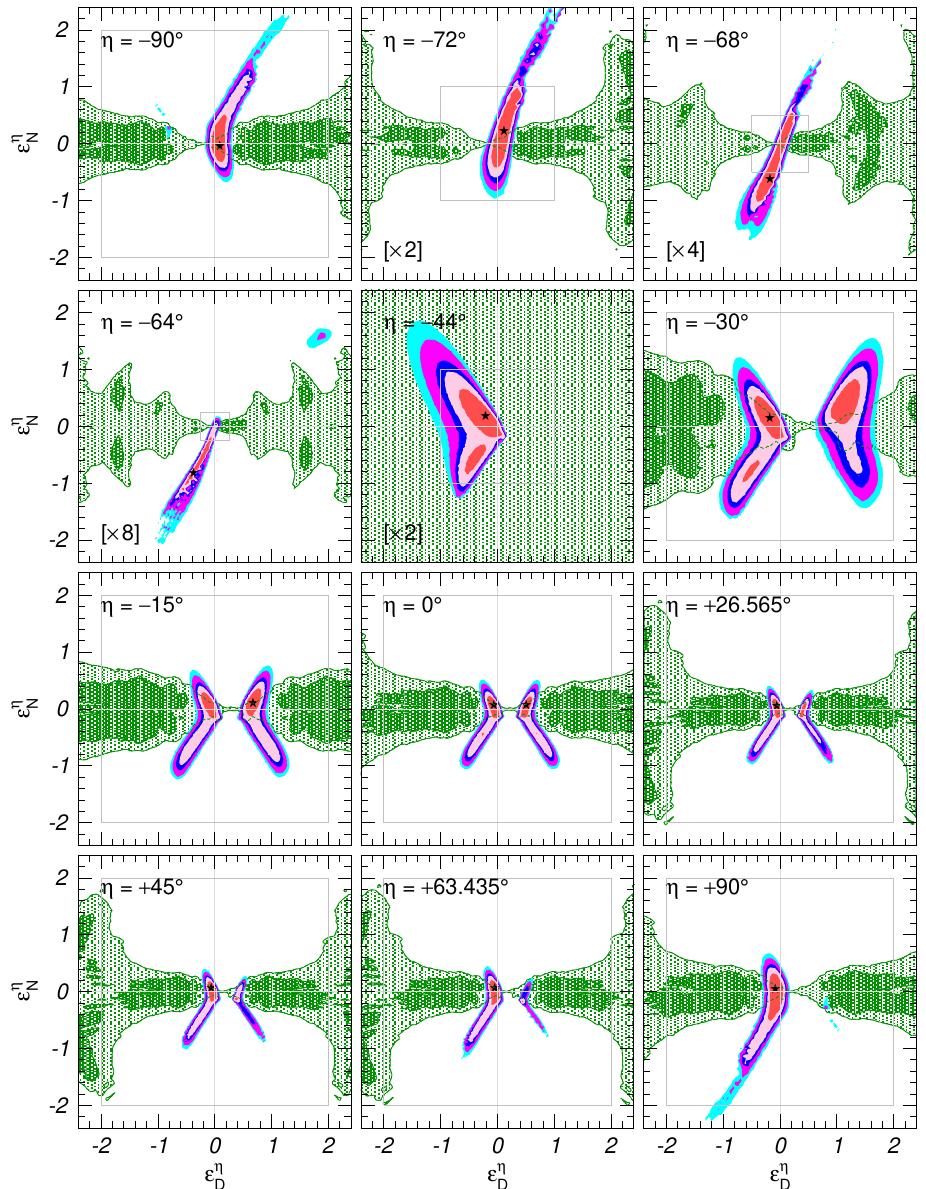
Figure 2 . Two-dimensional projections of the 1 σ , 90%, 2 σ , 99% and 3 σ CL (2 dof) allowed regions from the analysis of solar and KamLAND data in the presence of non-standard matter potential for the matter potential parameters ( ε η , ε η ) , for sin 2 θ 13 = 0 . 022 and after marginalizing over the D N oscillation parameters. The best fit point is marked with a star. The results are shown for fixed values of the NSI quark coupling parameter η . The panels with a scale factor “ [ × N ] ” in their lower-left corner have been “zoomed-out” by such factor with respect to the standard axis ranges, (cid:0) (cid:1) hence the grey square drawn in each panel always corresponds to max | ε η | , | ε η | = 2 and has the D N same size in all the panels. For illustration we also show as shaded green areas the 90% and 3 σ CL allowed regions from the analysis of the atmospheric and LBL data. Note that, as a consequence of the periodicity of η , the regions in the first ( η = − 90 ◦ ) and last ( η = +90 ◦ ) panels are identical up to an overall sign